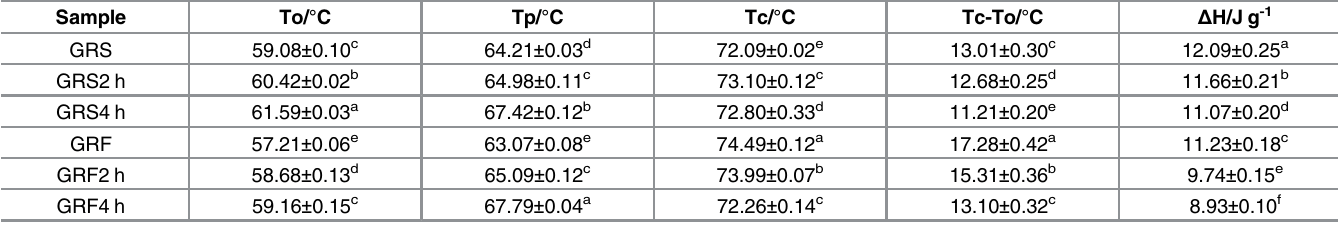
Values expressed are means ± standard deviations (n = 3). Values of means followed by different lowercase letters in the same column are signi fi cantly different ( p <